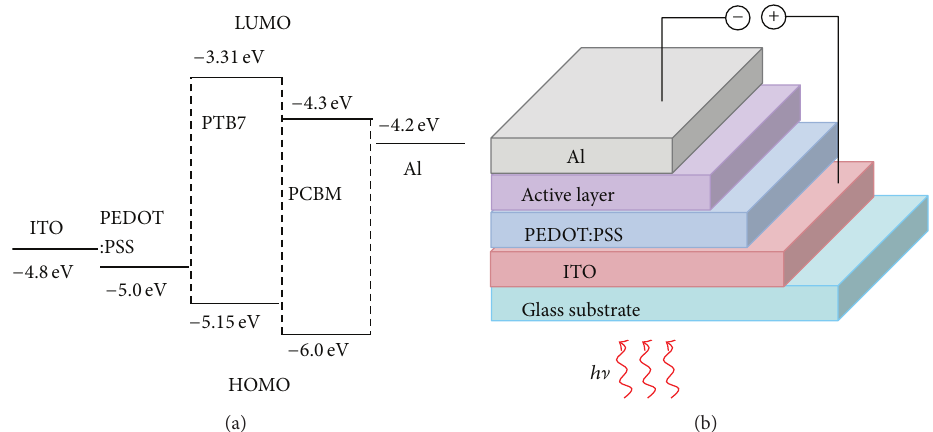
Figure 2: Schematics of the (a) energy band structure of the OTFSC with hole transfer layer of PEDOT:PSS and blended active layer of PTB7:PC 71 BM and (b) cross section view of OTFSC